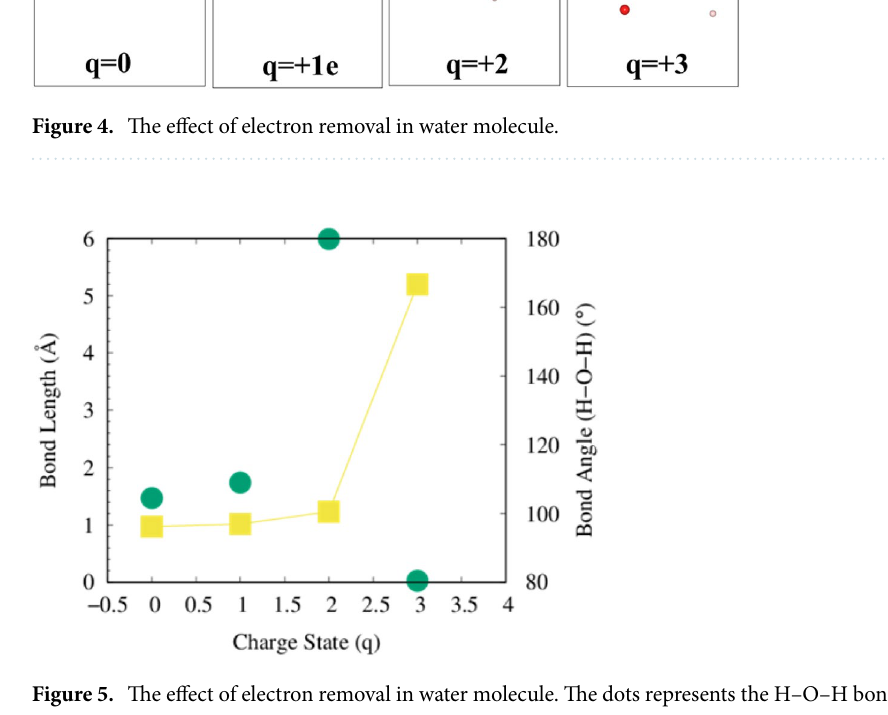
Figure 5. The effect of electron removal in water molecule. The dots represents the H–O–H bond